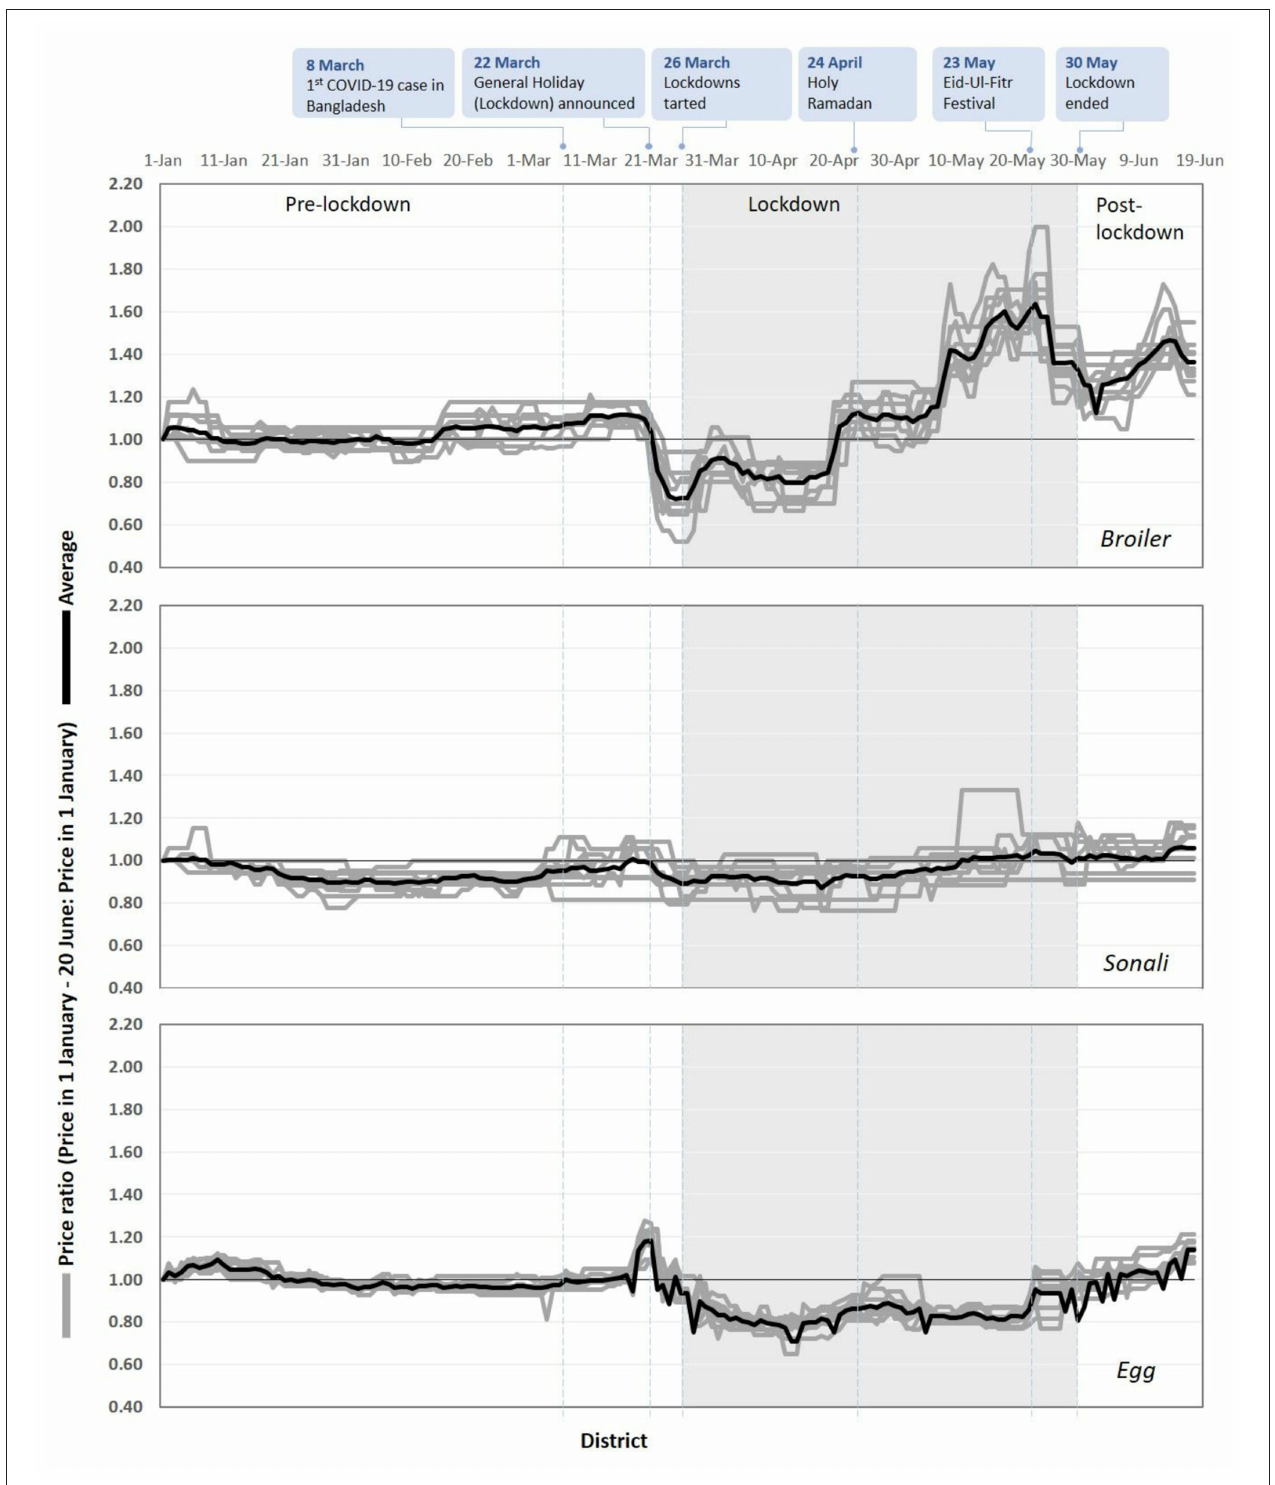
FIGURE 1 | Variations of farm gate price for the period 1/1/2020 to 20/6/2020 in 10 administrative districts of Bangladesh (Barisal, Bogura, Chattogram, Comilla, Cox’s Bazar, Gazipur, Jashore, Mymensingh, Rajshahi, and Tangail).